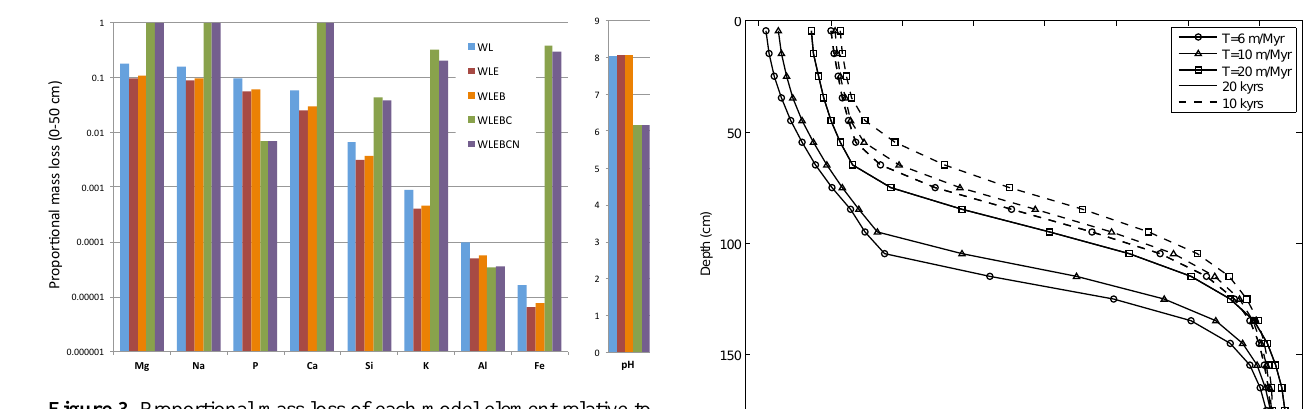
Figure 3. Proportional mass loss of each model element relative to the amount in the parent material and mean pH for the top 50cm of the soil profile after 20 kyrs of soil development for each of the model simulations (WL = weathering and leaching, E = erosion, B = bioturbation, C = organic carbon and N = nutrient cycling).